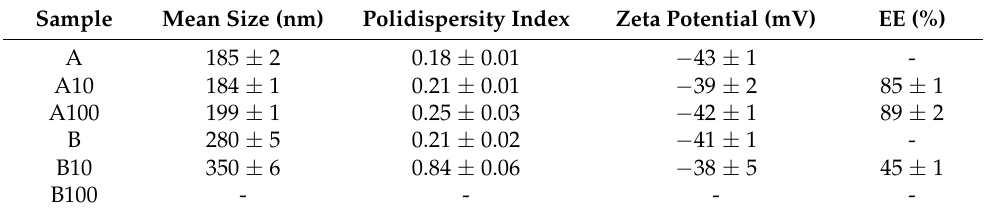
Table 3. Physicochemical and technological characterization of oleuropein-loaded ufasomes.